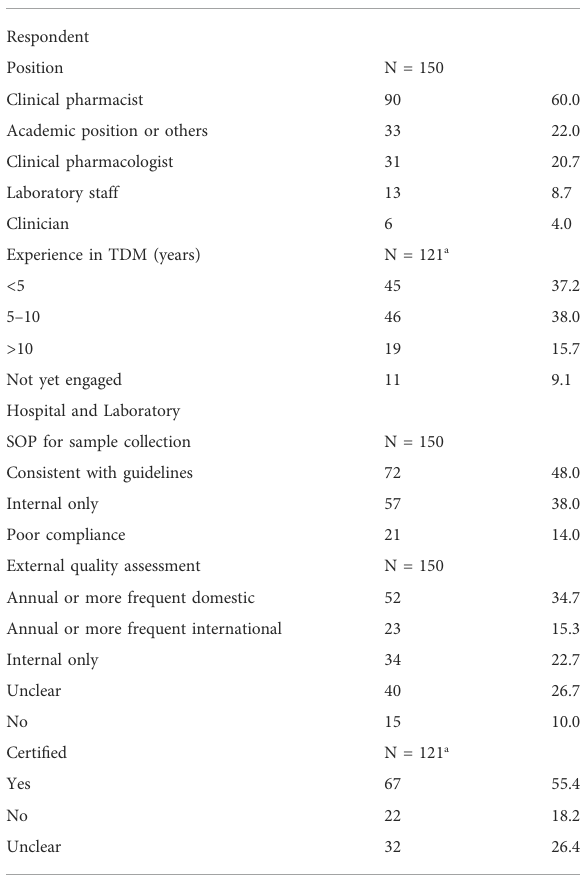
TABLE 2 Respondent and hospital